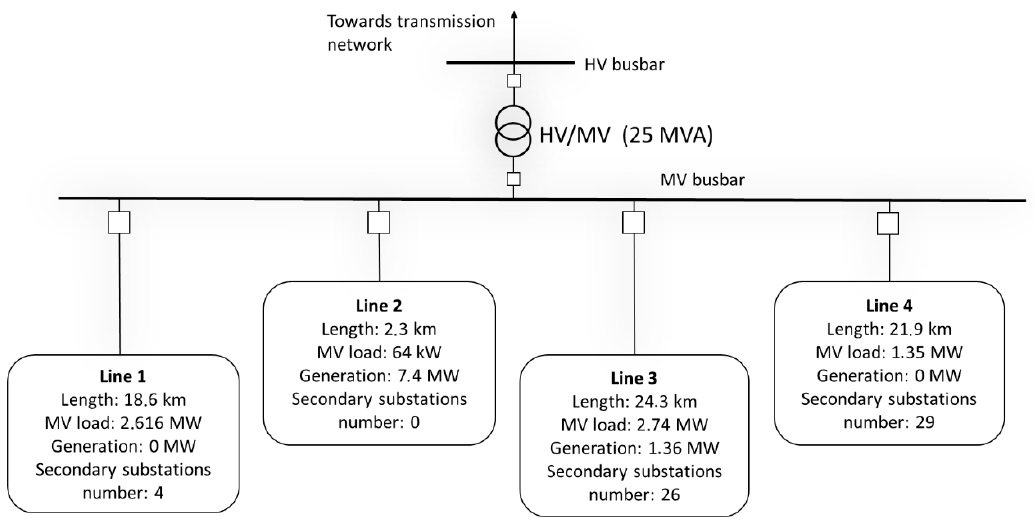
Figure 1. e-distribuzione distribution grid.